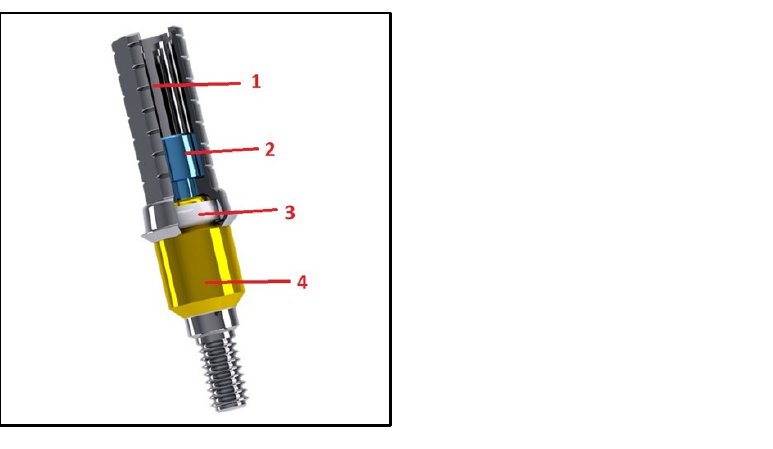
Figure 1. The OT-Bridge system (Rhein83, Bologna, Italy) composed with the extragrade (1), the prosthetic screw (2), Seeger (3), OT-Equator (4).